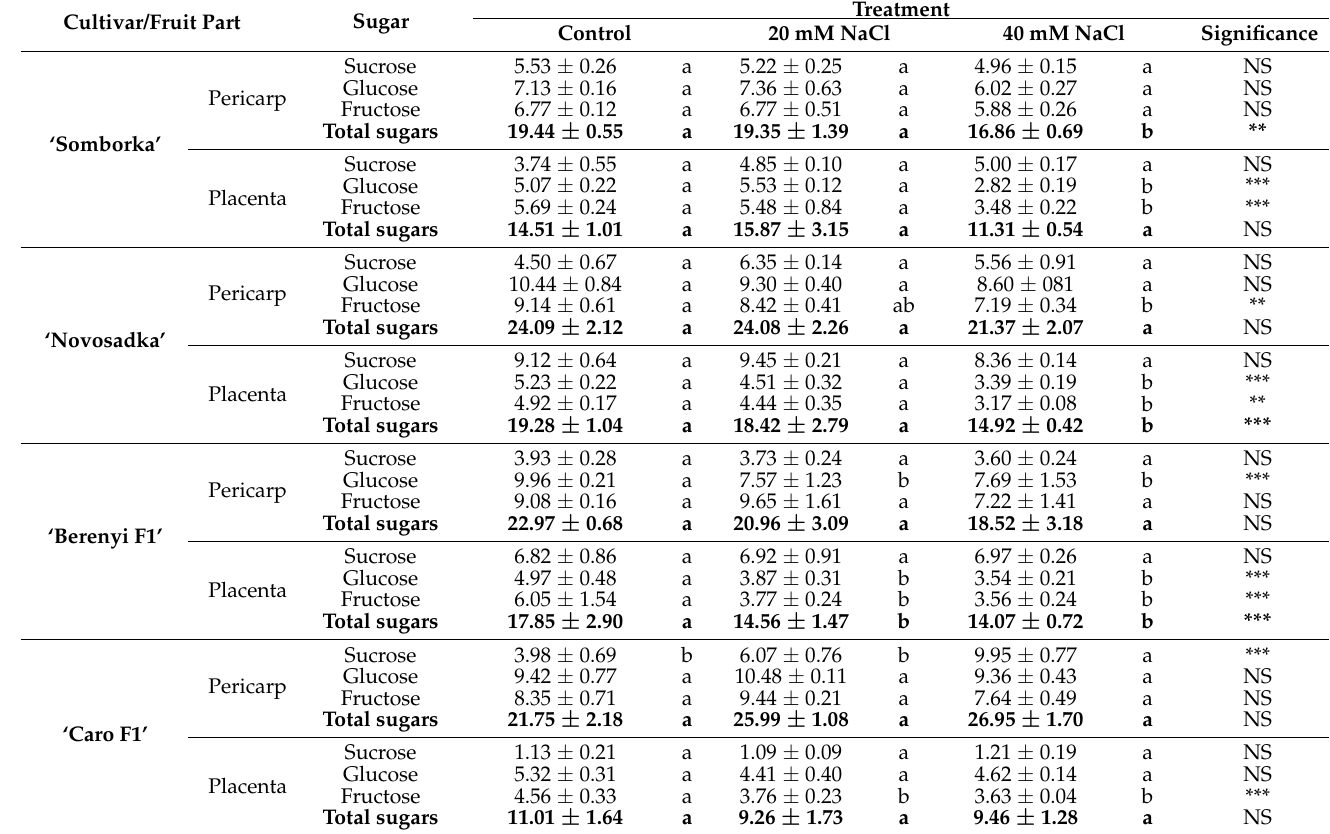
Table 1. Individual and total sugar contents (g 100 g − 1 DW; mean ± SE) of three fruit parts of the four pepper ( Capsicum annuum L.) cultivars under salt stress.